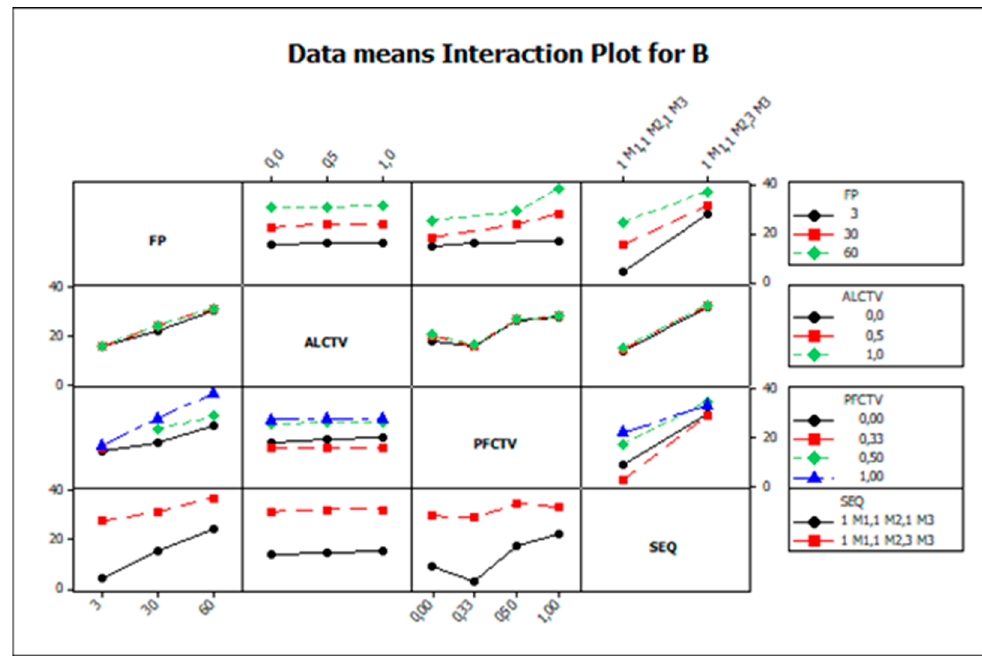
Figure 7. Interaction plot of the input parameters FP, ALCTV, PFCTV, SEQ for W.